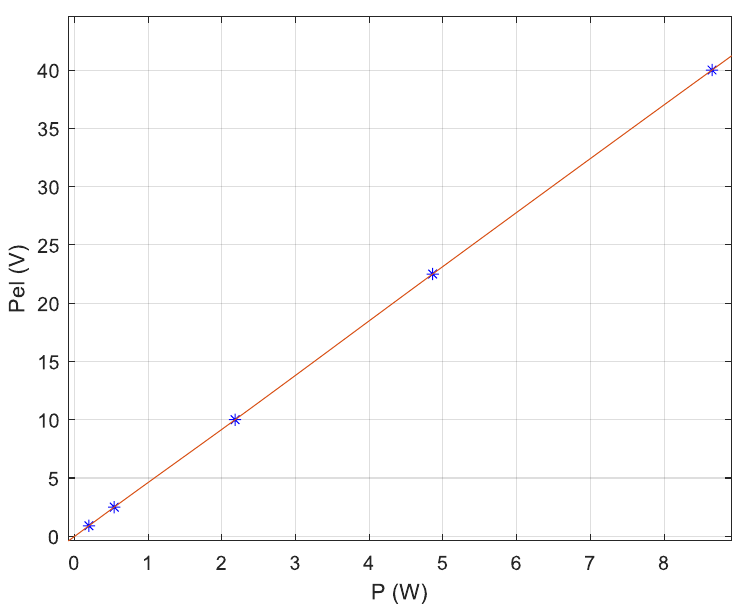
Figure 9. Static diagram of the electrical power transducer.